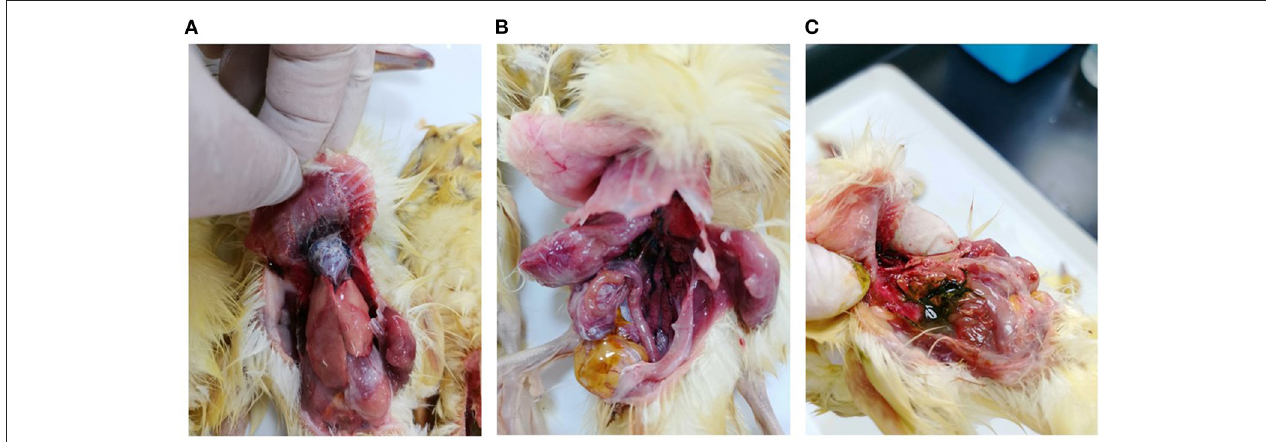
FIGURE 1 | Pathological lesions of clinical samples. (A) Urate deposition in the heart; (B) Urate deposition in the mesenterium; (C) Urate deposition in the